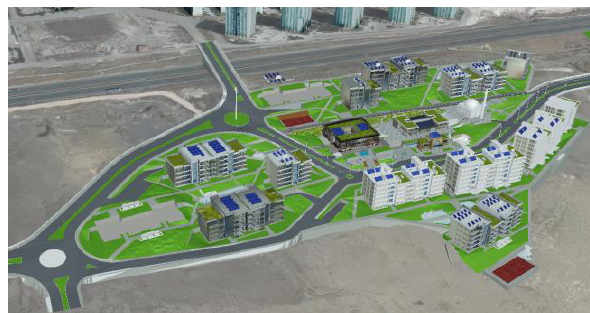
Figure 5. An overview of the georeferenced model